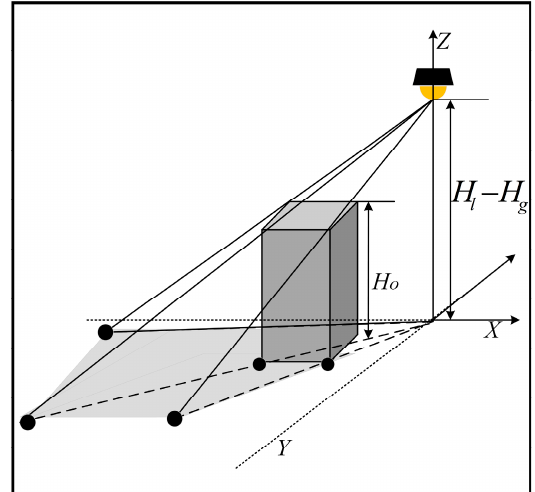
Table 1. Simulation parameters related to working environment.